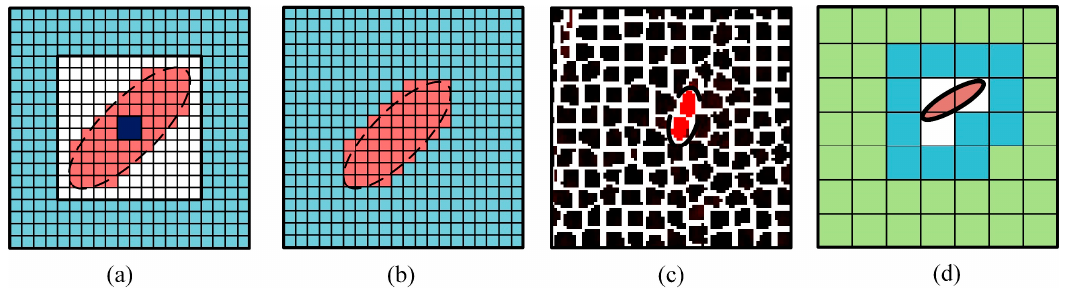
Figure 2. The detection windows. ( a ) Two-parameter constant false alarm rate (CFAR) window. ( b ) Candidate region window. ( c ) Superpixel window. ( d ) Block detection window.